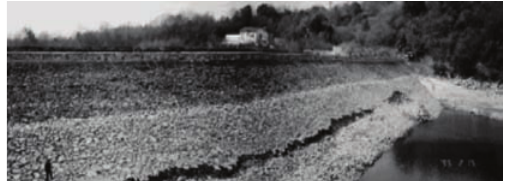
Figure 3: Cross section, layers, and stress points of Kitayama